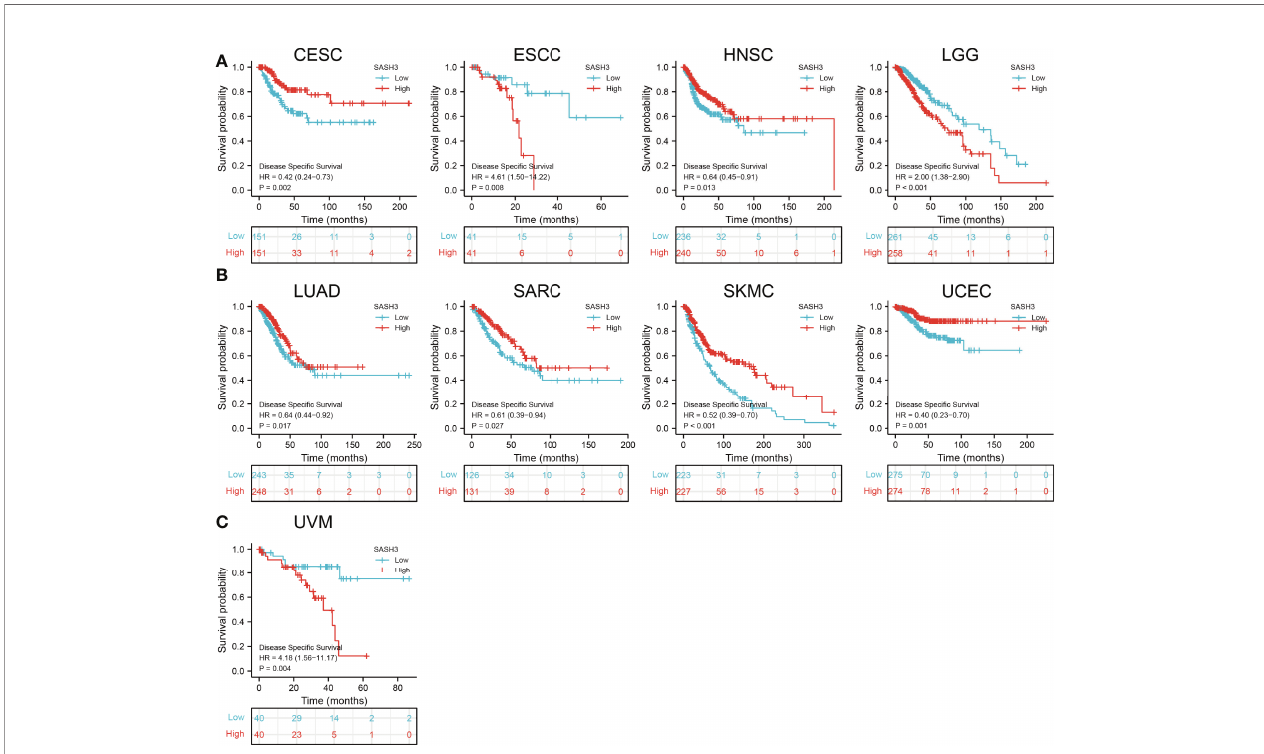
FIGURE 3 | SASH3 expression correlated with the disease-speci fi c survival of pan-cancer. (A) The disease-speci fi c survival for SASH3 in CESC, ESCC, HNSC, and LGG. (B) The disease-speci fi c survival for SASH3 in LUAD, SARC, UCEC, and SKCM. (C) The disease-speci fi c survival for SASH3 in UVM.